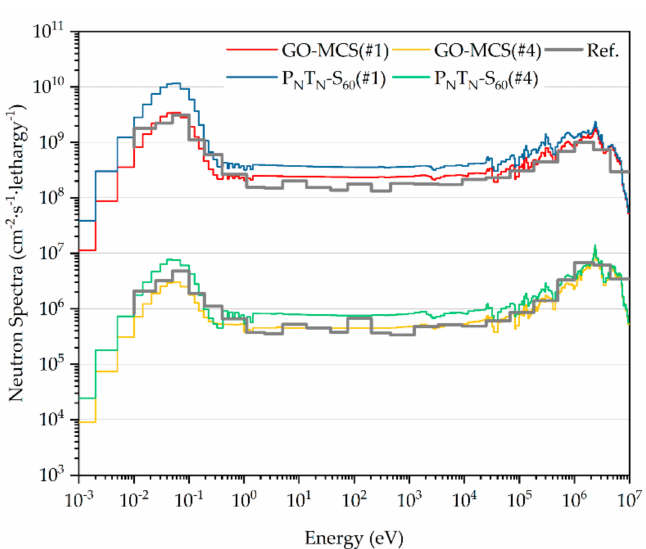
Figure 10. Neutron spectrum for the IRI-TUB benchmark.